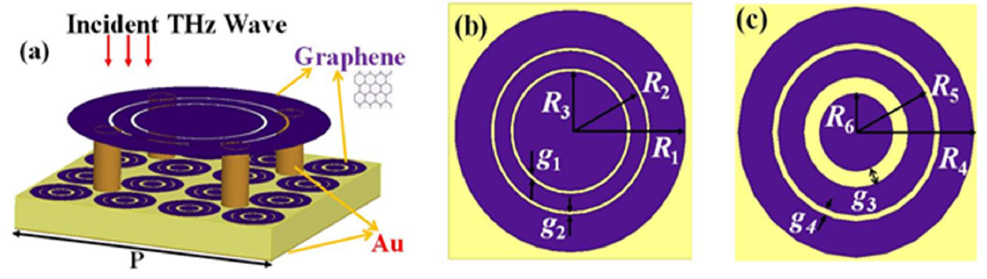
Figure 1. Proposed meta-absorber with bilayer graphene and Au cylinders. ( a ) Schematic of the proposed absorber. ( b ) Top view of the unit cell of top layer, ( c ) Top view of the unit cell of second graphene